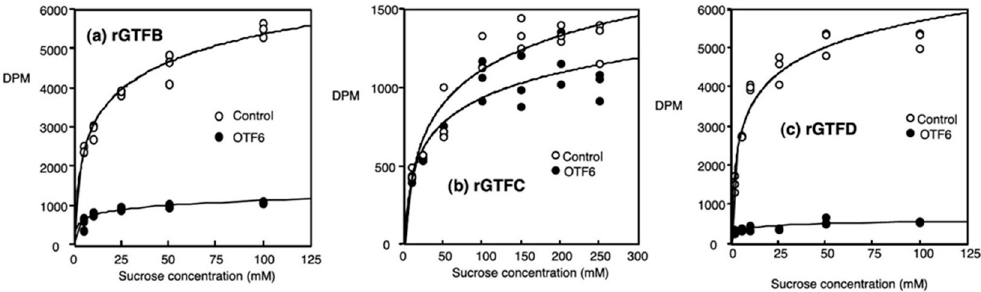
Figure 9. Changes in the quantity of glucan produced by recombinant GTFs. GTF activity was measured with [14C-glucose] sucrose. The OTF6 concentration in all displayed data was 1.0 mg/mL. Data are given in counts per minute. GTFs and sucrose were reacted without ( ○ ) and with ( ● ) OTF6. Cited from Reference [73] with permission.